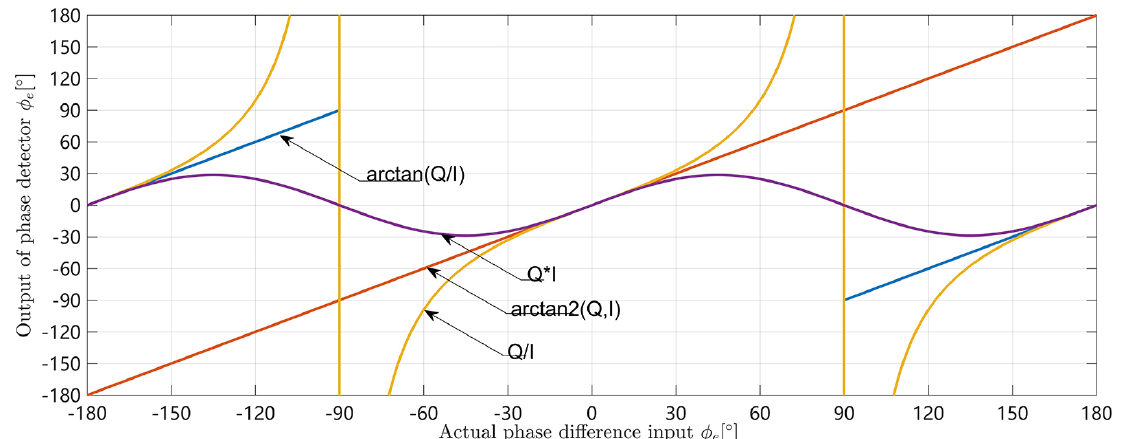
Figure 8. Comparison of PLL